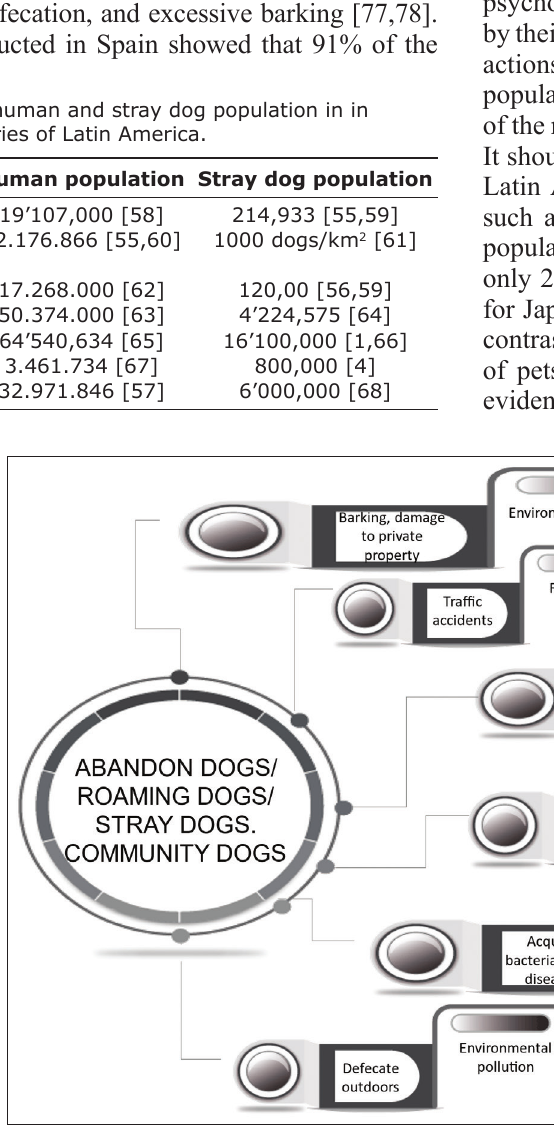
Figure-3: Adverse factors of human abandonment and free-rooming dogs for public health. Problems begin with the lack of responsibility of owners who abandon their pets in the street and finally, it could cause all the problems mentioned at the figure.